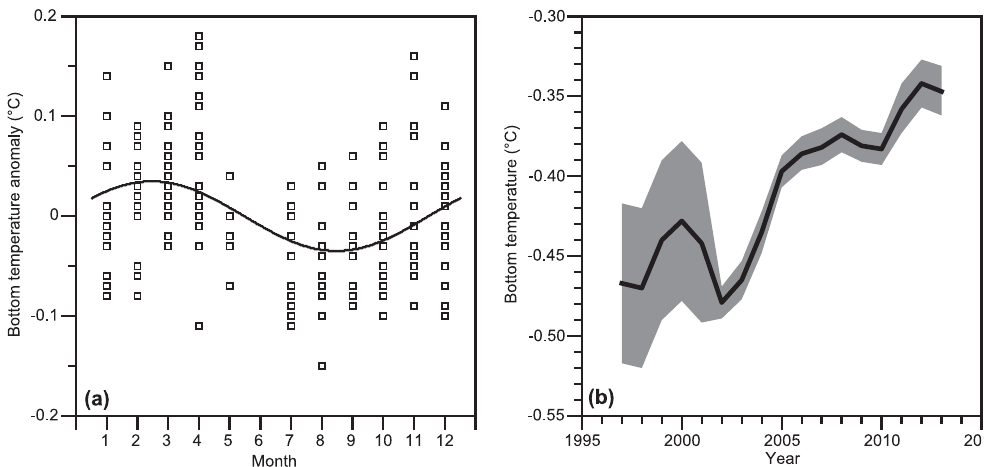
Figure 4. Seasonal (a) and long-term (b) variations of bottom temperature at FB 1995–2015. (a) Each square represents the deviation for 1 month from the 3-year-running mean. The curve represents the iteratively determined sinusoidal seasonal fit; (b) 3-year-averaged transport (black curve) with the shaded area representing the uncertainty